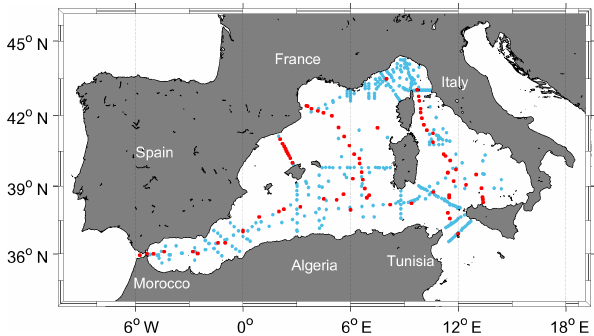
Figure 1. Map of the western Mediterranean Sea showing the bio- geochemical stations (in blue) and the five reference cruise stations (in